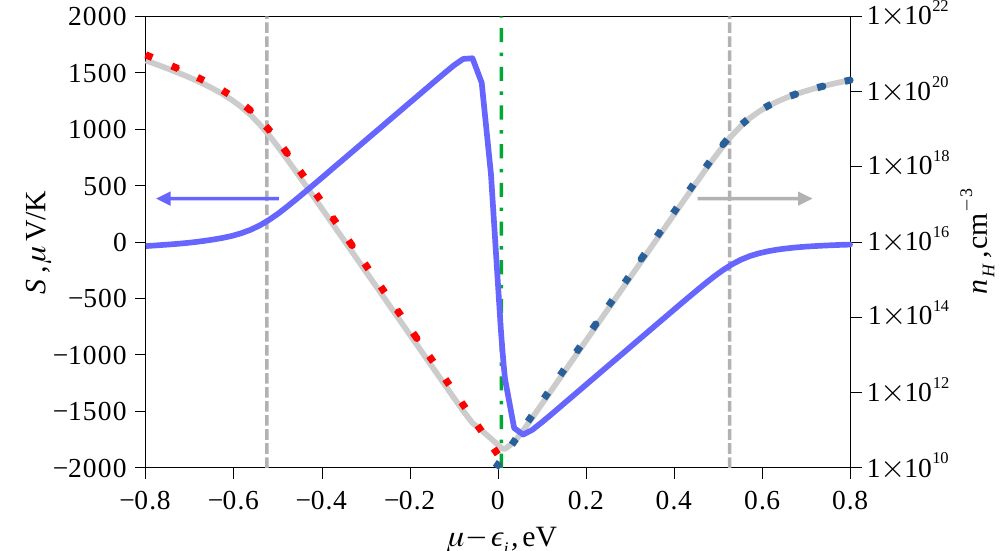
Figure 10. The dependence of the Seebeck coefficient (blue curve, left axis) and the Hall concentration (gray curve, right axis) on the chemical potential at 300 K. The vertical gray dashed lines show the boundaries of the band gap, and the green dash-dotted line shows the position of the chemical potential at equal concentrations of electrons and holes. Red (blue) dots on the Hall concentration plot show the concentrations of holes (electrons) separately. The chemical potential is counted from the middle of the band gap (cid:101) i